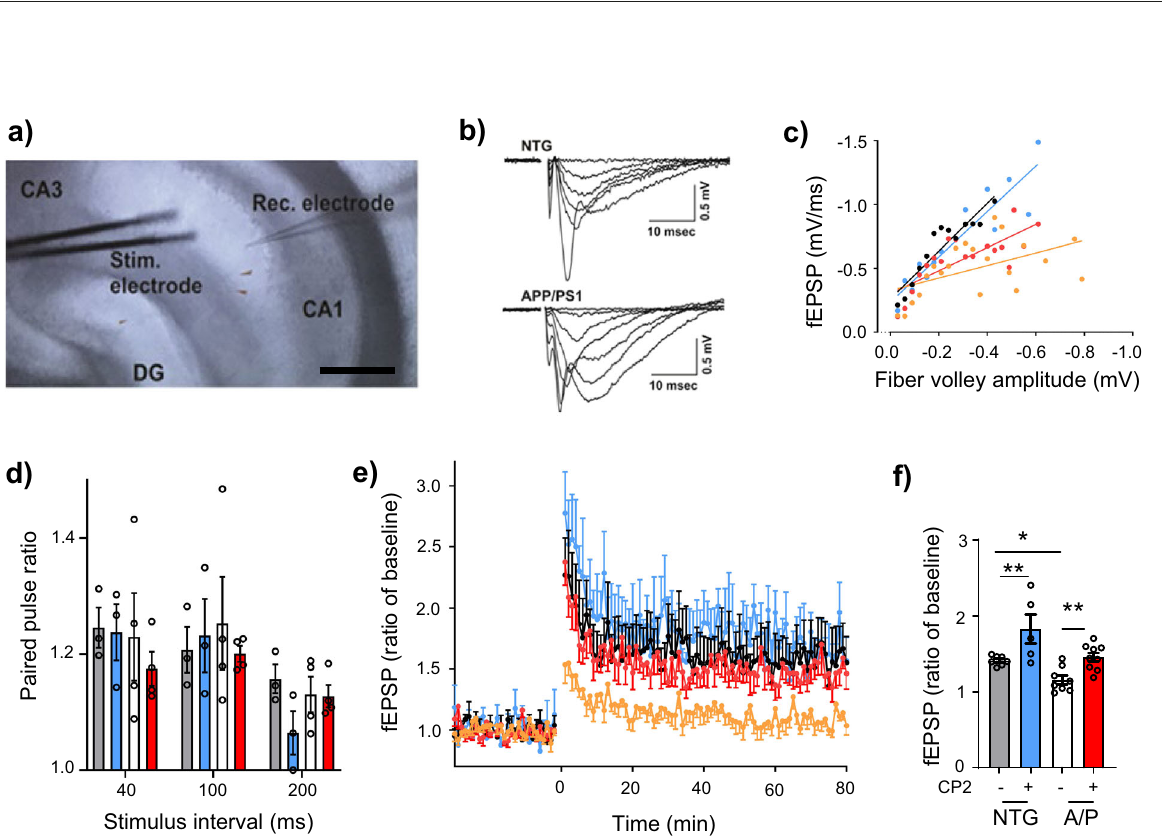
Fig. 4 CP2 treatment reduces levels of A β , in fl ammation and oxidative stress in symptomatic APP/PS1 mice. a Representative images of A β plaques visualized using 4G8 antibody in S1BF cortex of NTG and APP/PS1 mice. Scale bar, 100 μ m. b Levels of A β plaques are signi fi cantly reduced in S1BF and hippocampus in CP2-treated APP/PS1 mice estimated using 4G8 antibody shown in a . APP/PS1 (Ctx), n = 6 mice per group; APP/PS1 + CP2 (Ctx), n = 5 mice per group; APP/PS1 (Hipp), n = 6 mice per group; APP/PS1 + CP2 (Hipp), n = 5 mice per group. c – f Differential centrifugation and ELISA revealed decreased levels of total A β 42 in brain homogenates from CP2-treated APP/PS1 mice ( c ). Levels of soluble A β 40 and 42 obtained using TBS ( d ) and TBSX ( e ) fractions were increased, while concentrations of the least soluble A β 40 and 42 were decreased in brain fractions obtained using Gdn ( f ). c – f APP/PS1, n = 17 mice per group; APP/PS1 + CP2, n = 10 mice per group. g CP2 treatment induces AMPK activation, reduces the activity of GSK3 β , and activates autophagy in brain tissue of APP/PS1 mice. Each lane represents an individual mouse. h , j Representative images of GFAP + ( h ) and Iba1 + ( j ) staining in the S1BF in vehicle and CP2-treated NTG and APP/PS1 mice. Scale bar, 100 µ m. i , k Quanti fi cation of GFAP ( i ) and Iba1 ( k ) staining from h and j , respectively. NTG, n = 6 mice per group; NTG + CP2, n = 6 mice per group; APP/PS1, n = 6 mice per group; APP/PS1 + CP2, n = 4 mice per group. l – o CP2 reduces pro-in fl ammatory markers in plasma of NTG and APP/PS1 mice. NTG, n = 13 mice per group; NTG + CP2, n = 17 mice per group; APP/PS1, n = 20 mice per group; APP/PS1 + CP2, n = 16 mice per group. p Levels of lipid peroxidation measured using MDA assay were signi fi cantly reduced in brain tissue of CP2-treated NTG and APP/PS1 mice. NTG, n = 4 mice per group; NTG + CP2, n = 4 mice per group; APP/PS1, n = 5 mice per group; APP/PS1 + CP2, n = 5 mice per group. q – t Concentrations of ceramides (C16, C18, C24, C24-1) were signi fi cantly reduced in blood collected from CP2-treated APP/PS1 mice and measured using targeted metabolomics. n = 5 mice per group. All mice were 23-month-old. Data are presented as mean ± S.E.M. A two-way ANOVA with Fisher ’ s LSD post-hoc test was used for data analysis. For the comparison between vehicle and CP2-treated APP/PS1 groups ( b – f ), an unpaired Student t -test was used for statistical analysis. * P < 0.05; ** P < 0.01; *** P < 0.001; **** P < 0.0001.